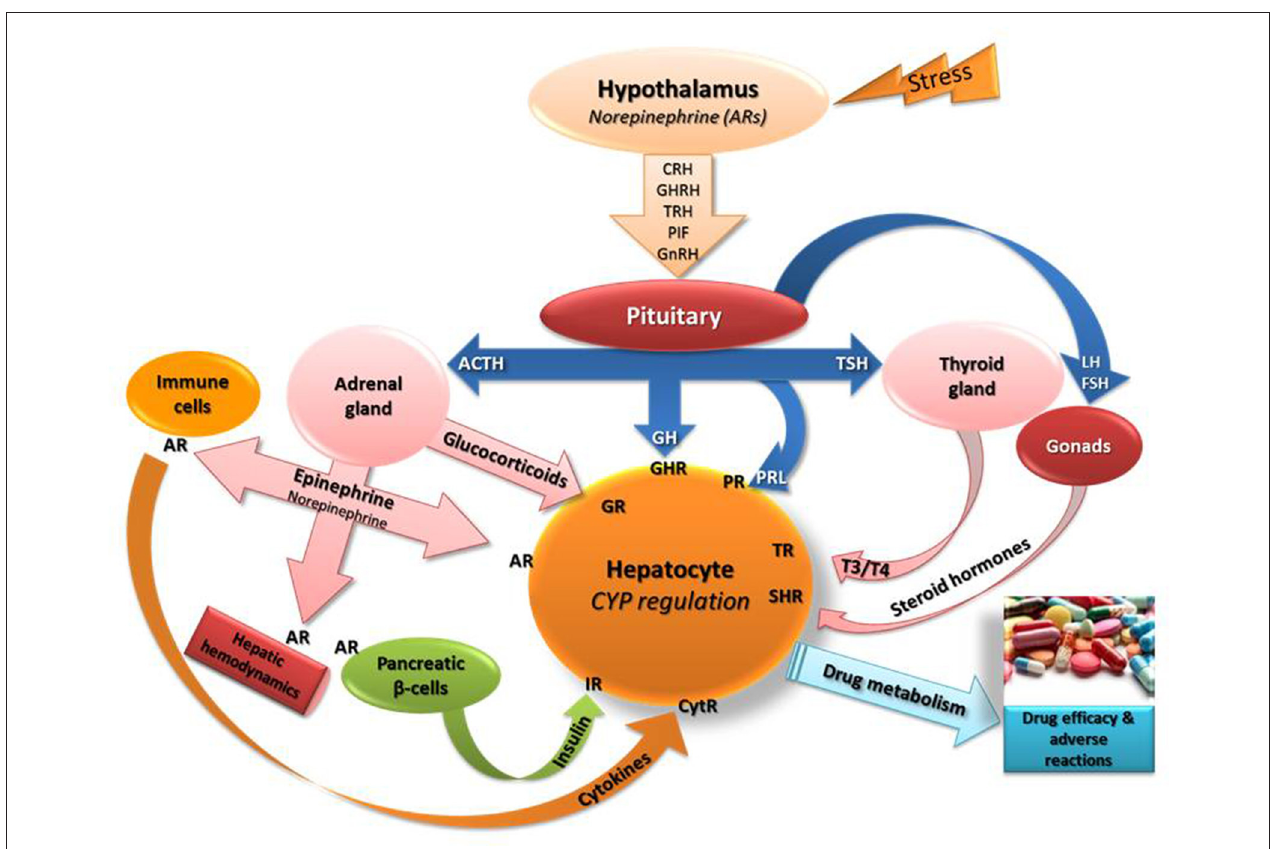
FIGURE 1 | Schematic of the stress-induced neuroendocrine responses that presumably affect the regulation of the main drug-metabolizing cytochromes (CYP). Epinephrine and norepinephrine bind to adrenergic receptors (AR) in the periphery including hepatocytes, immune cells (stimulate release of cytokines), hepatic blood vessels (modify liver hemodynamics) and on pancreatic beta-cells (control insulin release positively via β 2-ARs or negatively via α 2-AR). Stress stimulates the secretion of norepinephrine in the hypothalamus that controls the release of several releasing factors regulating the secretion of hormones from the pituitary ( Konstandi, 2013; Konstandi et al., 2014). The left side of the scheme indicates the effect of hypothalamic-pituitary-adrenal axis stimulation by stress on hepatic CYP regulation. CRH, corticotropin releasing hormone; GHRH, growth hormone releasing hormone; TRH, thyrotropin releasing hormone; PIF, prolactin inhibiting factor; GnRH, gonadotrophin releasing hormone; TSH, thyrotropin stimulating hormone; GH, growth hormone; T3, T4, thyroid hormones; ACTH, adrenocorticotropin hormone; PRL, prolactin; IR, insulin receptor; CytR, cytokine receptor; GHR, growth hormone receptor; TR, thyroid hormone receptor; GR, glucocorticoid receptor; SHR, steroid hormone